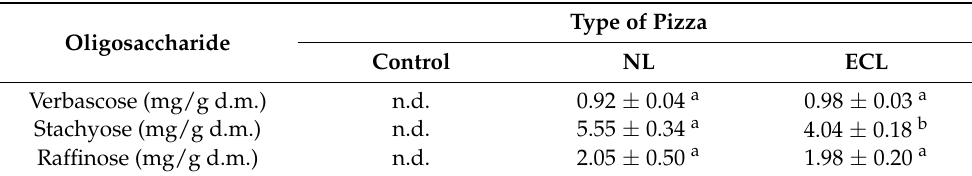
Table 5. Content of oligosaccharides in the experimental GF pizza samples. NL = native lentil flour; ECL = extruded-cooked lentil flour. Type of Pizza Oligosaccharide Control NL ECL Verbascose (mg/g d.m.) Stachyose (mg/g d.m.) Raffinose (mg/g d.m.)